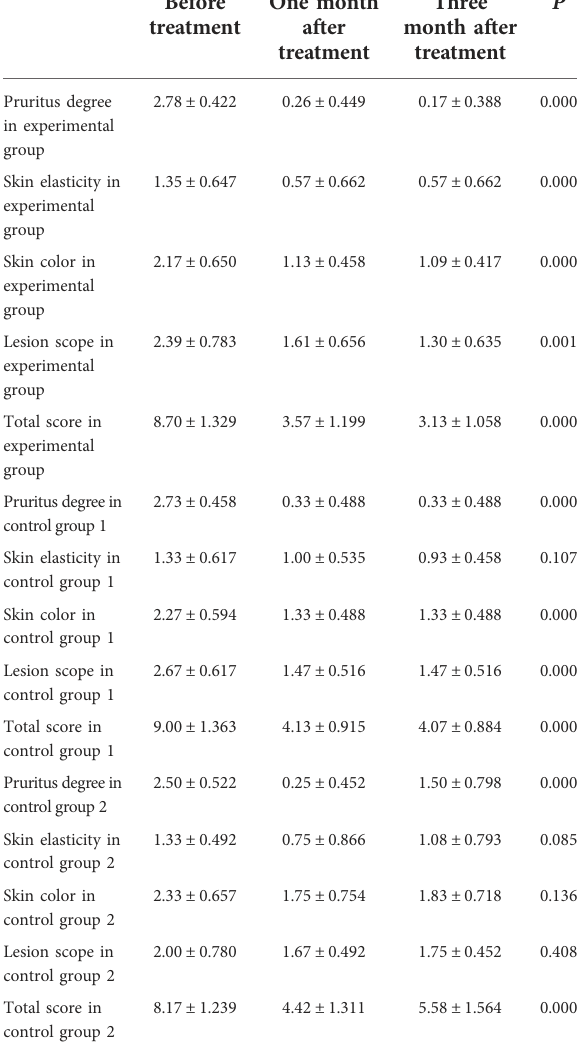
TABLE 3 Comparison of curative effect among three groups before and after treatment. Before